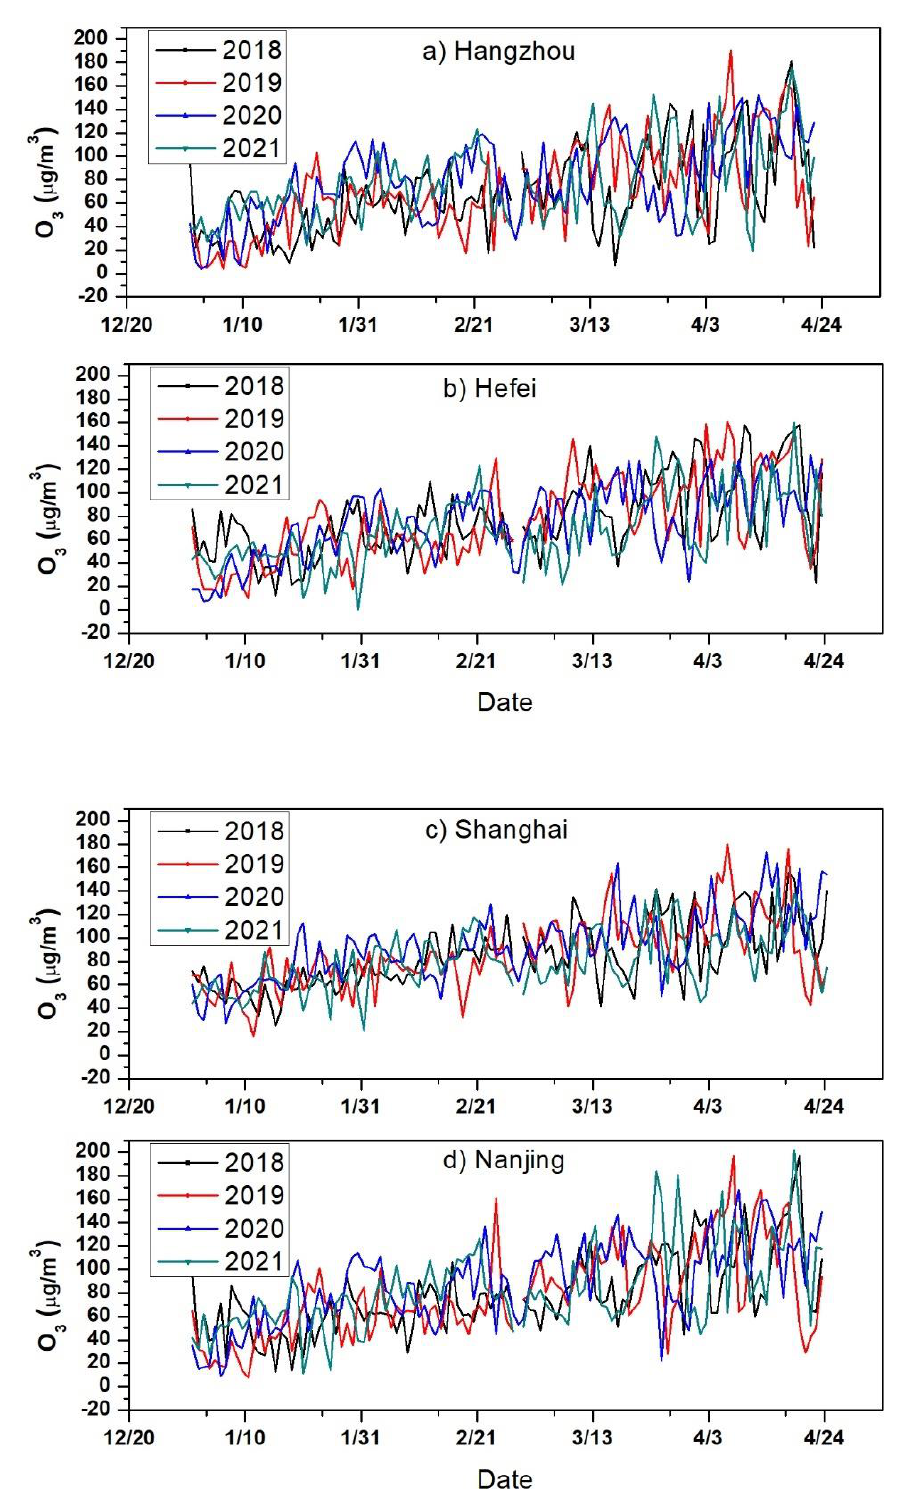
The trend in O 3 concentration is opposite to that of other atmospheric pollutants. There is no impact of COVID-19 Lockdown on level of tropospheric O 3 . This has been depicted by the time series in Figure 4.